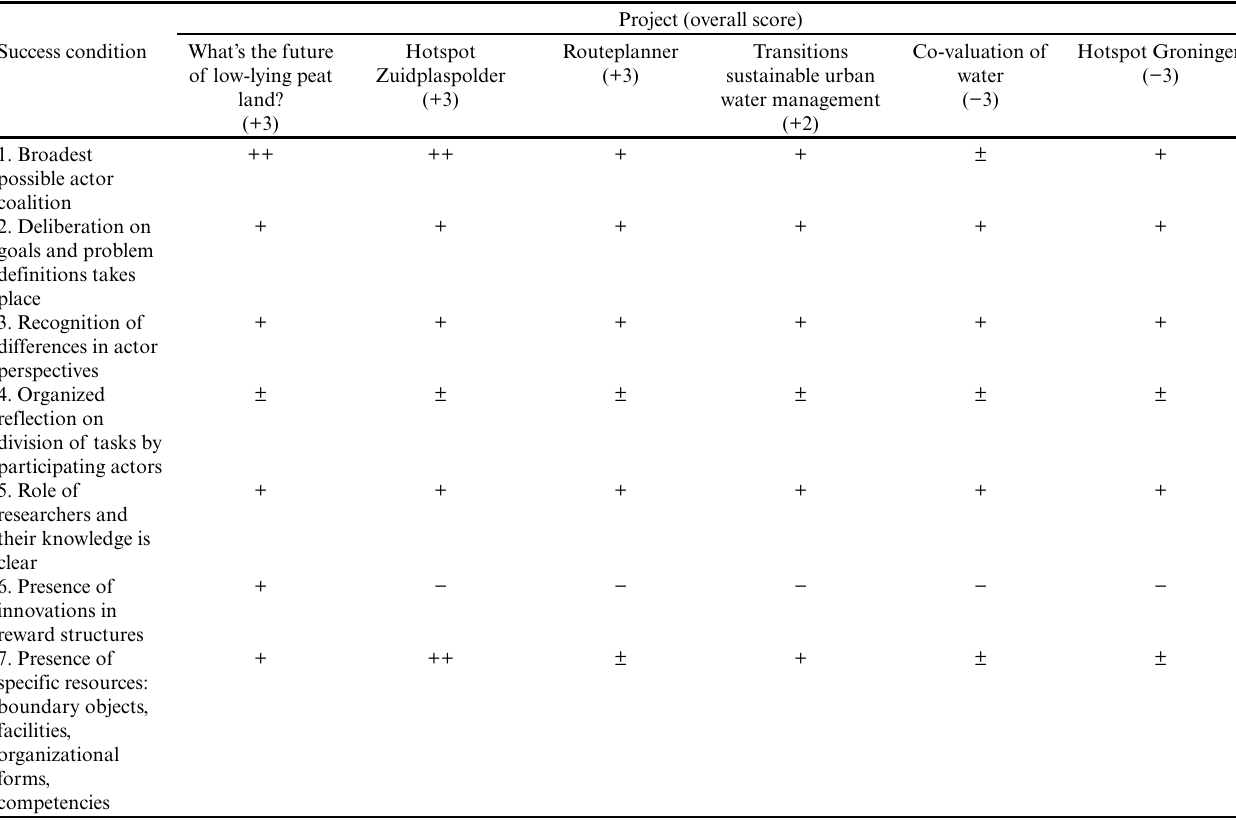
Table 7. Projects ranked according to the presence of success conditions in the